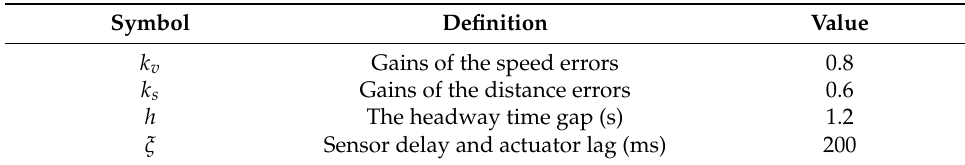
Table 3. Parameters value of the ACC